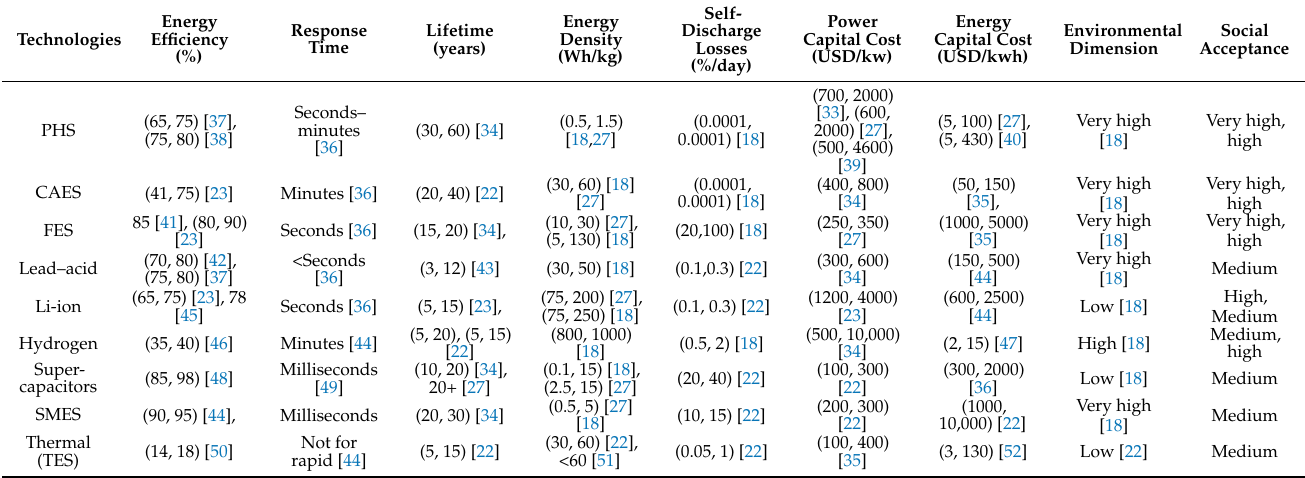
Table 2. The characteristics and relevant value ranges of energy storage